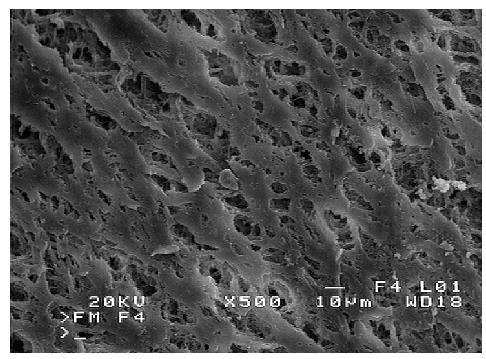
Figure 7. SEM image of the external surface of new Accurel PP S6/2 membrane.